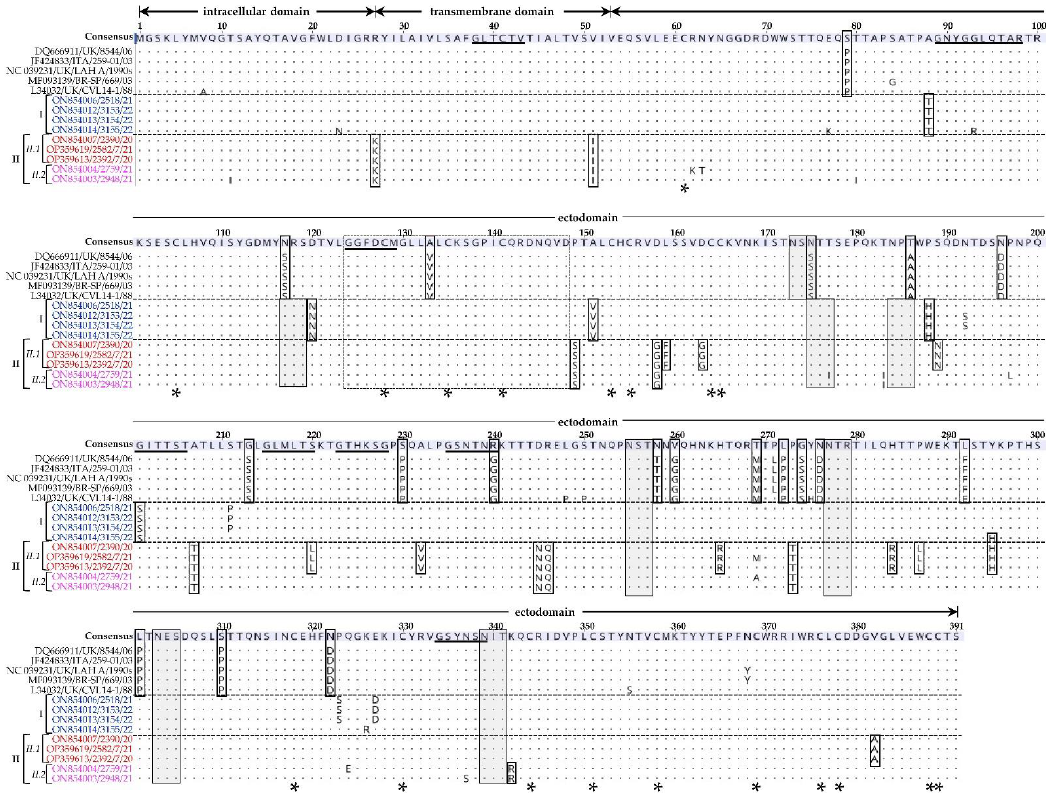
Figure 4. Analysis of aa variations and domains of the G-protein sequences of the Mexican aMPV-A isolates identified in the current study compared to other aMPV-A strains. The horizontal dotted lines group the Mexican sequences (highlighted in color) based on the phylogenetic clusters I, II.1, and II.2 (see Figure 3). The dots in the aligned sequences indicate identical aa residues. The horizontal double-headed arrows above the consensus sequence indicate the intracellular, transmembrane, and extracellular domains. Open boxes in the alignment indicate aa variations between the aligned sequences. Asterisks indicate conserved cysteine residues ( n = 19). A stretch of 25 aa residues (positions 124 – 148; highlighted in dotted open box) in the ectodomain is conserved in aMPV-A and B strains [2].Asterisks (*) indicate conserved cysteine residues (n = 19). Predicted N-linked glycosylation sites are highlighted in shaded boxes. N-myristylation sites are underlined in the consensus sequence. Isolate/strain names include the GenBank accession number, avian species, country code, and year of sample collection. The second component of the pneumovirus membrane is the highly antigenic but conserved F-glycoprotein. Phylogenetic clustering of the F-gene nt sequences separates the Mexican cluster I and II isolates in a distinct clade from other aMPV-A strains, all supported by high bootstrap values (Figure 5). The Mexican cluster I and II isolates have within-group mean p -values of 0.0056 and 0.0116, with overall nt similarities of 99.4% and 99.8%, respectively.